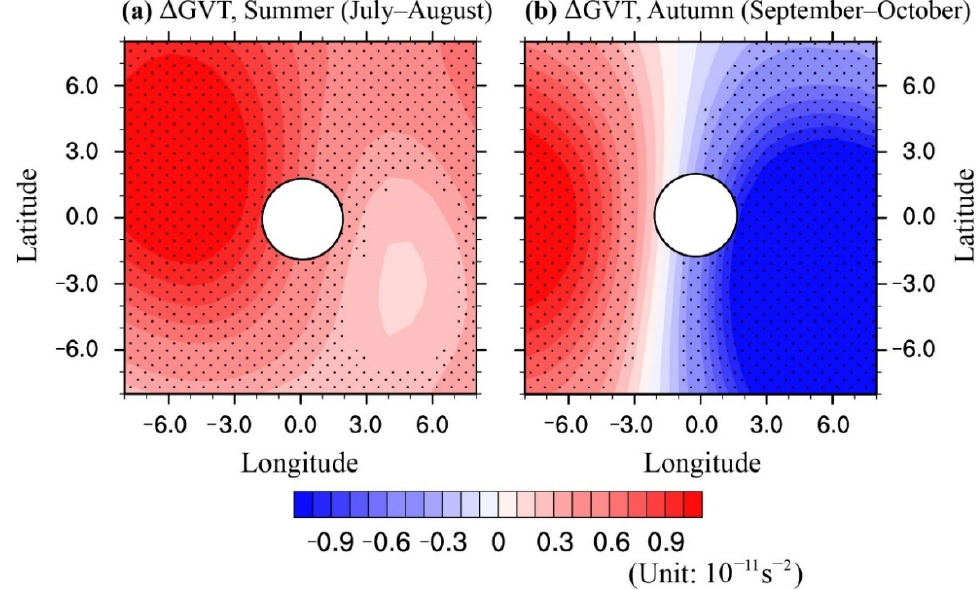
Figure 9. The composite difference in the GVT ( Δ GVT) in Equation (1) (shading; unit: 10 − 11 s − 2 ) be- tween VOR TCs and Environmental TCs. The white circles indicate the region of <2° longitude/lat- itude from the center of each TC: ( a ) TCs in summer (July–August) and ( b ) TCs in autumn (Septem- ber–October).